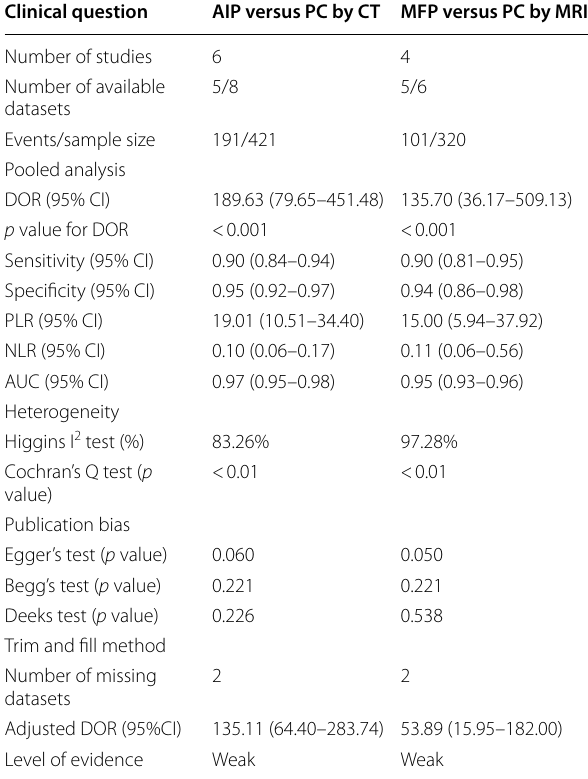
Table 4 Diagnostic performance of meta-analyzed clinical